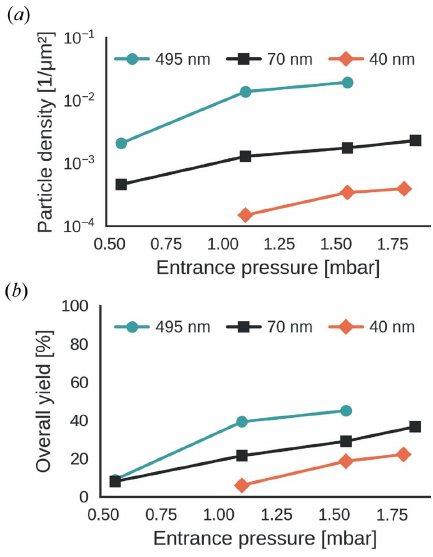
Figure 6 Particle density ( a ) and overall particle-injection yield ( b ) as a function of aerodynamic lens entrance pressure for polystyrene spheres with a range of distinct diameters (see legends). For ( a ) we normalized the values to the conditions of a particle solution with a concentration of 10 12 particles per ml and a flow rate of 1 m l min (cid:3) 1